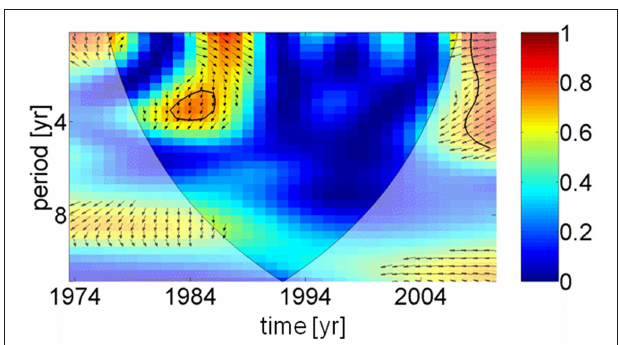
FIGURE 6 | Wavelet coherence and phase between AMO index and herring weight as function of time. For explanation see Figure 5 . Except in 1984, the figure indicates that no direct coherence exists between the temperature in the North Atlantic and the weight of 3 years old herring in the Baltic